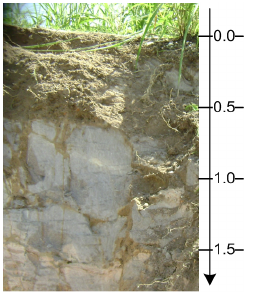
Figure 21. Profile of the Leptosol.